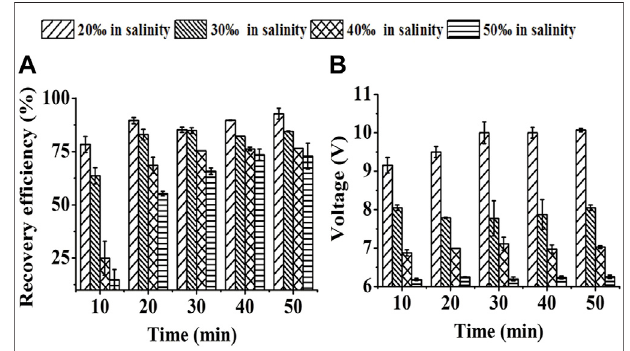
FIGURE 4 | Effect of medium salinity on SBEF when harvesting Nannochloropsis oculata at 450 mA: (A) recovery ef fi ciency; (B) operation voltage. Data were average ±standard deviation of three independent determinations.